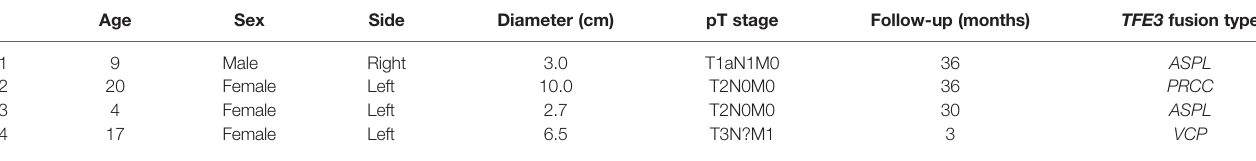
TABLE 1 | Clinicopathological characteristics of four cases of Xp11.2 renal cell